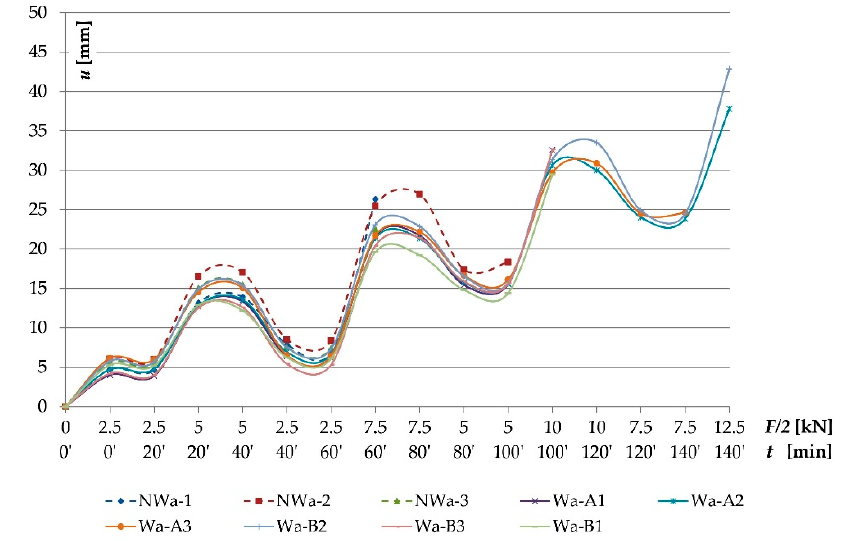
Figure 10. Chart of “ u-F / 2—including time during loading ” dependencies of the “Wa” type beams for sensor 2 (beam’s midspan).